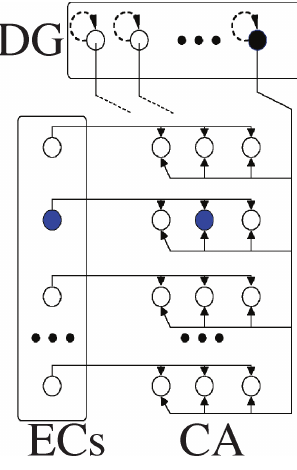
Figure 7. Transition cells (CA) inputs from the neurons coding for current location at time t (ECs) and at time t − 1 (DG) . In order to have a clear figure, the transition cells layer has only three possible transitions from a given starting place. For the same reason, connections from only one neuron of DG are